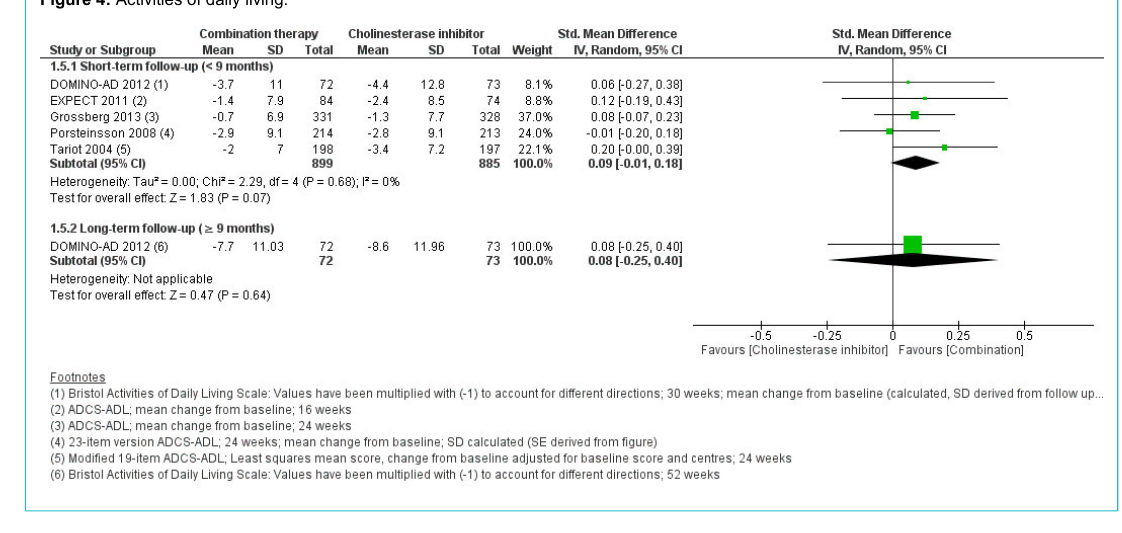
Figure 4: Activities of daily living.